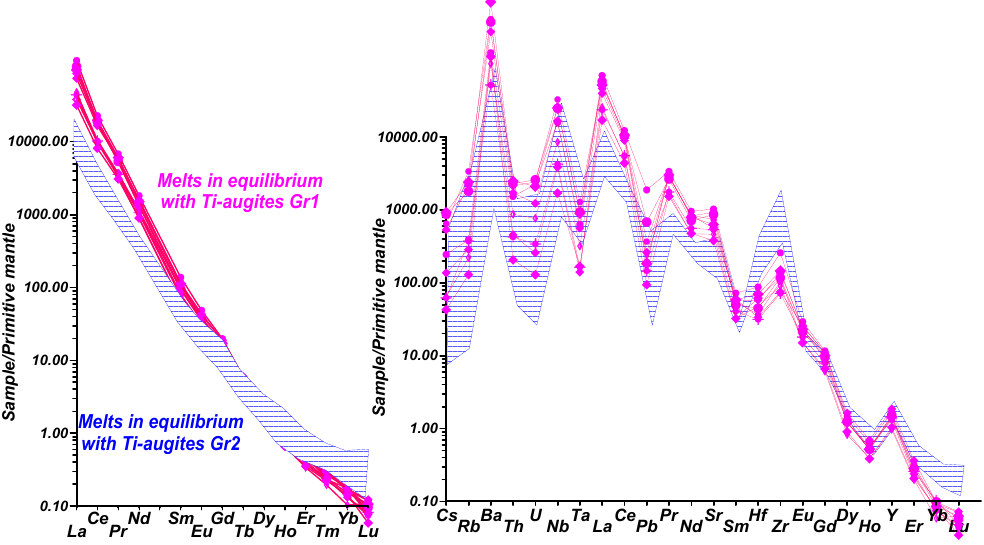
Figure 22. REE and TRE spectra of the melts in equilibrium with the Cpx from YUP Gr1-2 calculated with the partition coefficients after [79]. Normalized to primitive mantle [61] and chondrite C1 [68].